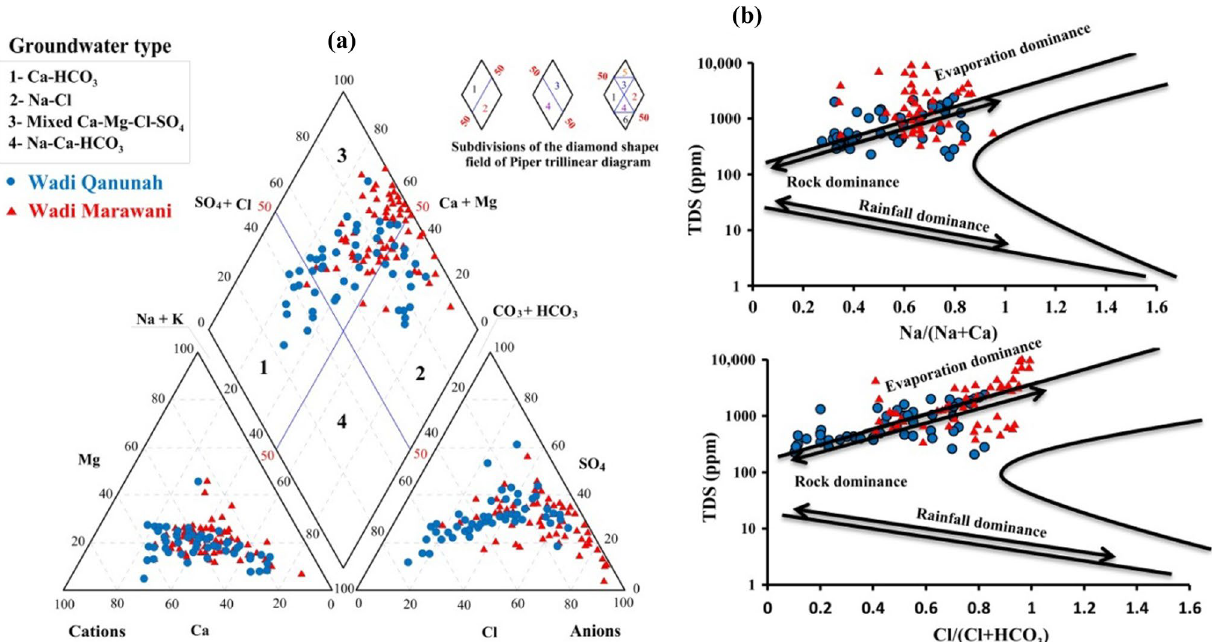
Fig. 7 Groundwater facies and their controlling mechanisms along Wadi Qanunah and Wadi Marawani basins: a Piper trilinear diagram and b Gibbs diagram